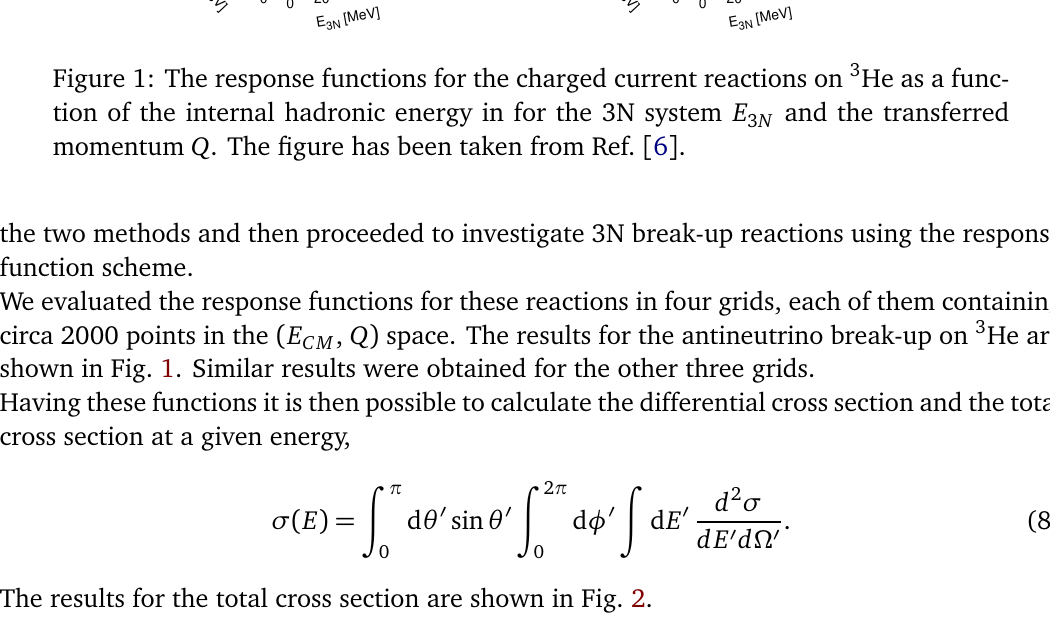
and the transferred 3 N